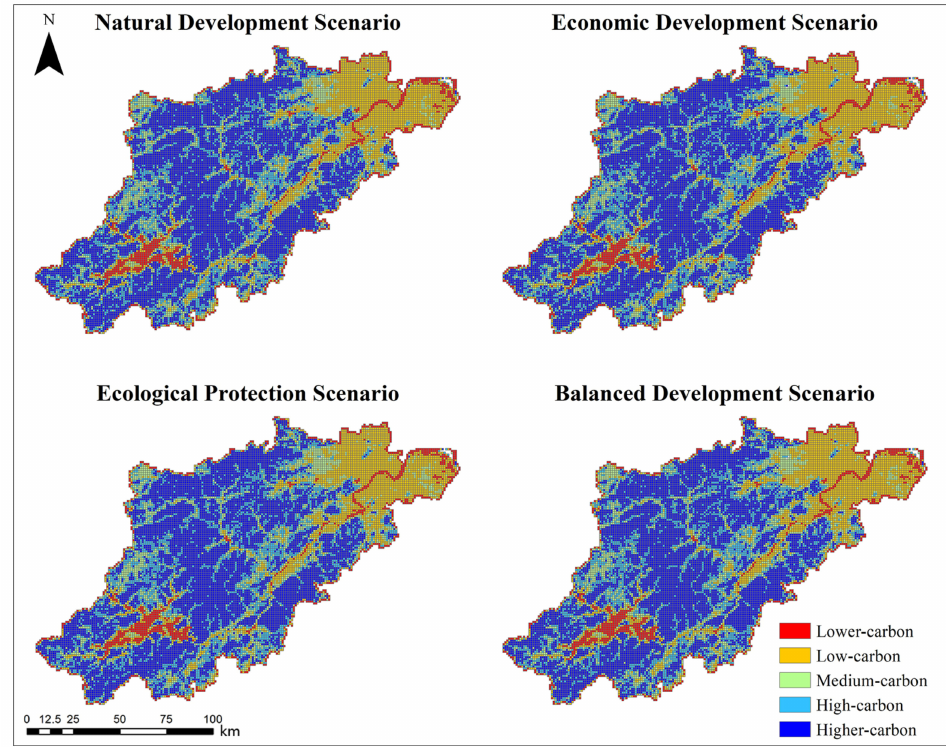
Figure 11. Carbon storage zoning in Hangzhou under the four scenarios in